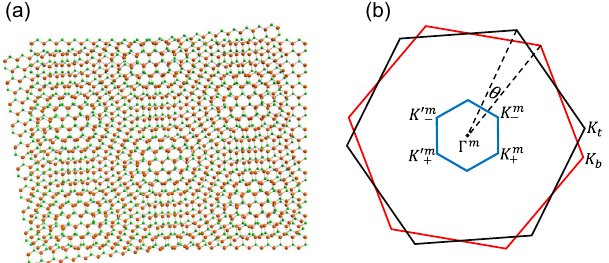
Fig. 1 Schematic fi gure and Brillouin zone of tWSe 2 . a A schematic fi gure of tWSe 2 moiré superlattice at a twist angle of 7 ∘ . b The original Brillouin zone of bottom (red) and top (black) layers and the folded moiré Brillouin zone (blue). θ is the twist angle between the two layers. K b , K t , K m moiré Brillouin zone corners. Γ m is the center of moiré Brillouin